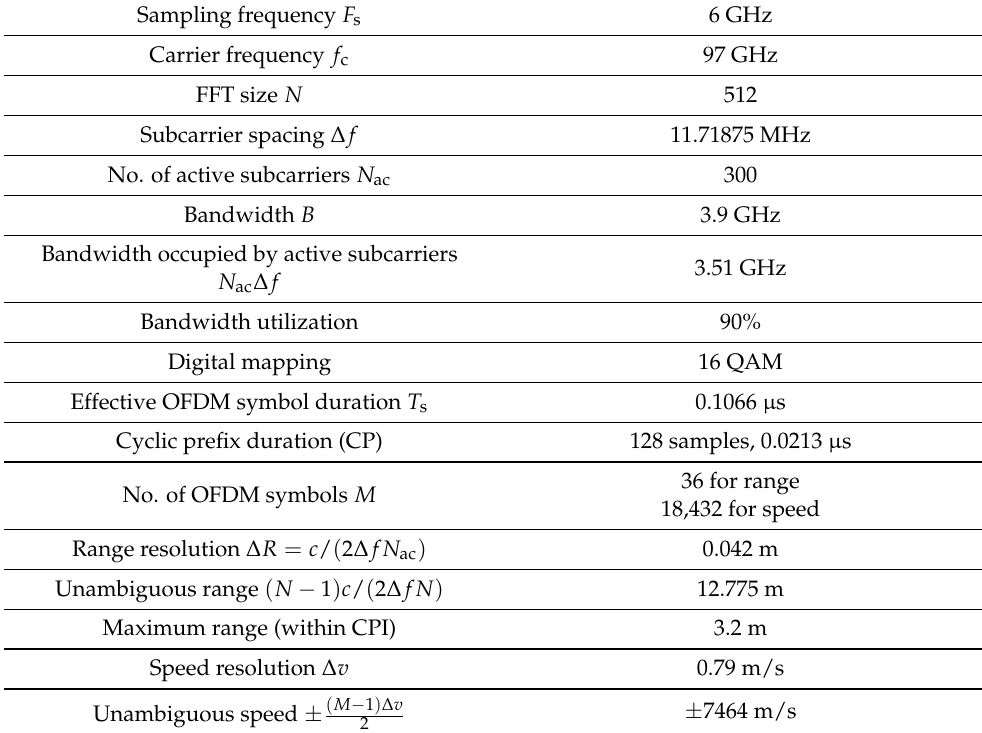
Table 2. Simulation